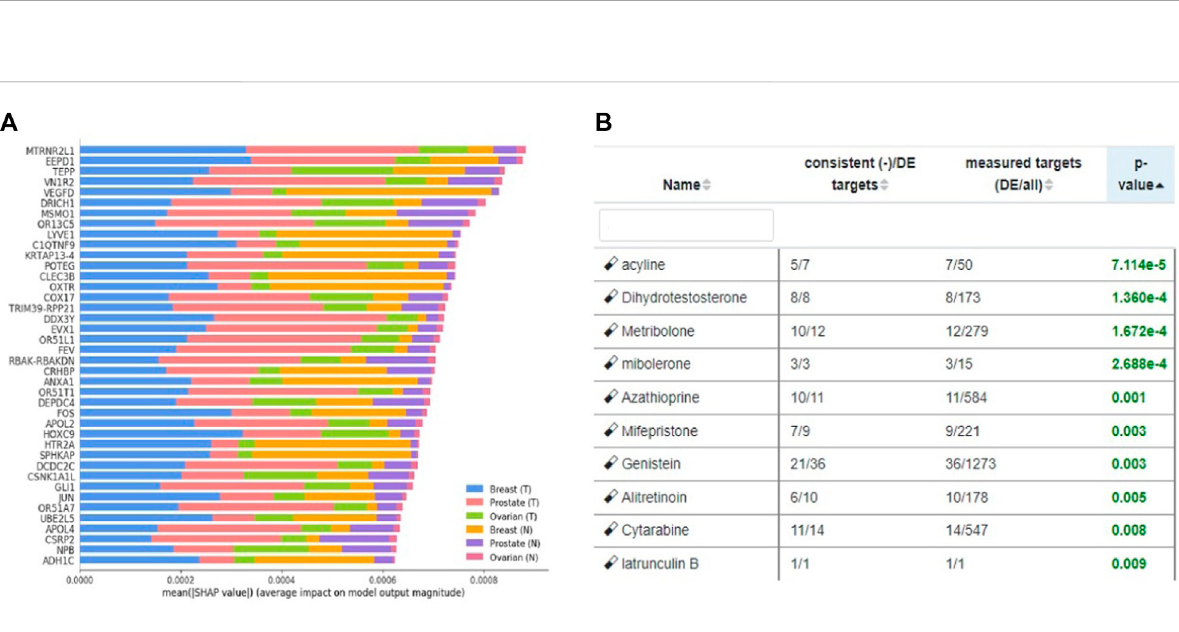
FIGURE 7 (A) Signi fi cantgenesidenti fi edusingSHAPbasedoncontributionscoresforallthreetissues(breast,prostateandovary).(T)Denotessolidtumor and (N) denotes solid normal tissue. Figure utilized from Zhou et al. (2021) (B) Top eight drugs proposed for repurposing using cross cancer